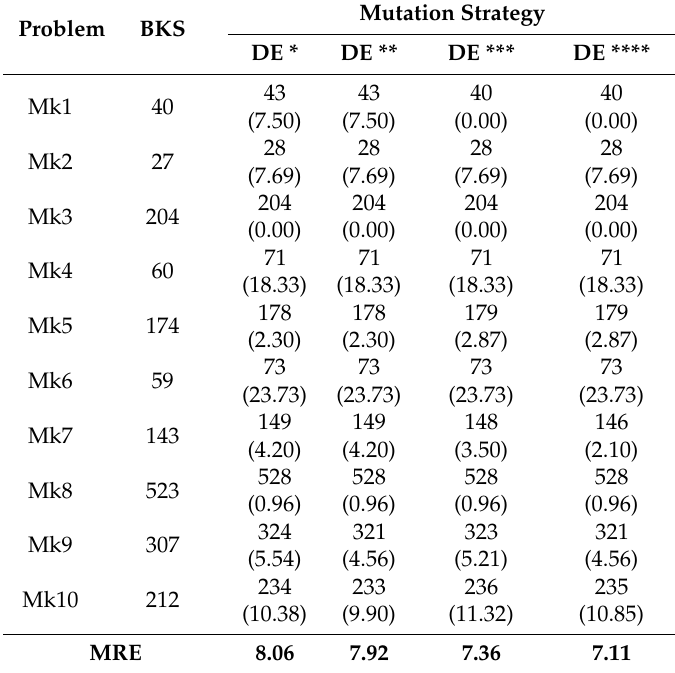
Table 15. Summary of solving the flexible job shop scheduling problem with sample problems Brandimarte [30].